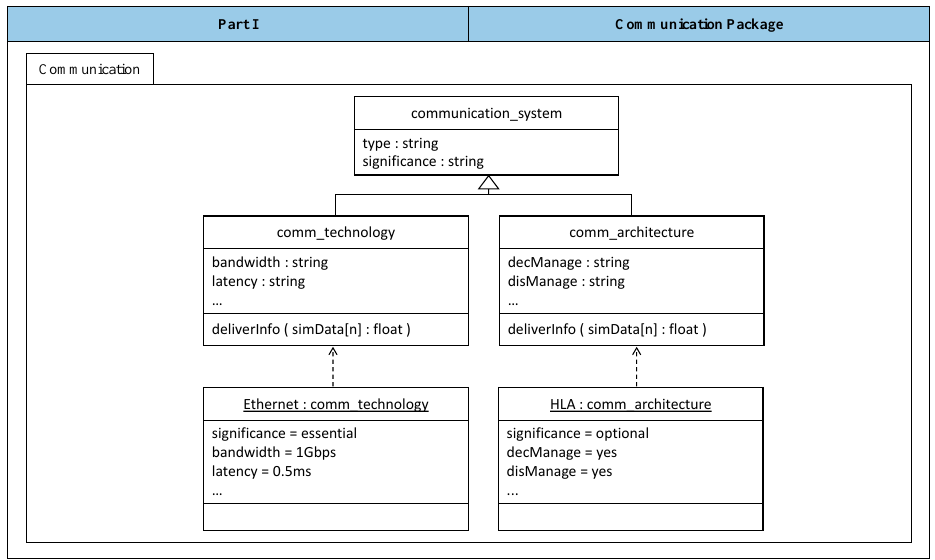
Figure 20. UML class diagram of the selected communication system components—package 2.